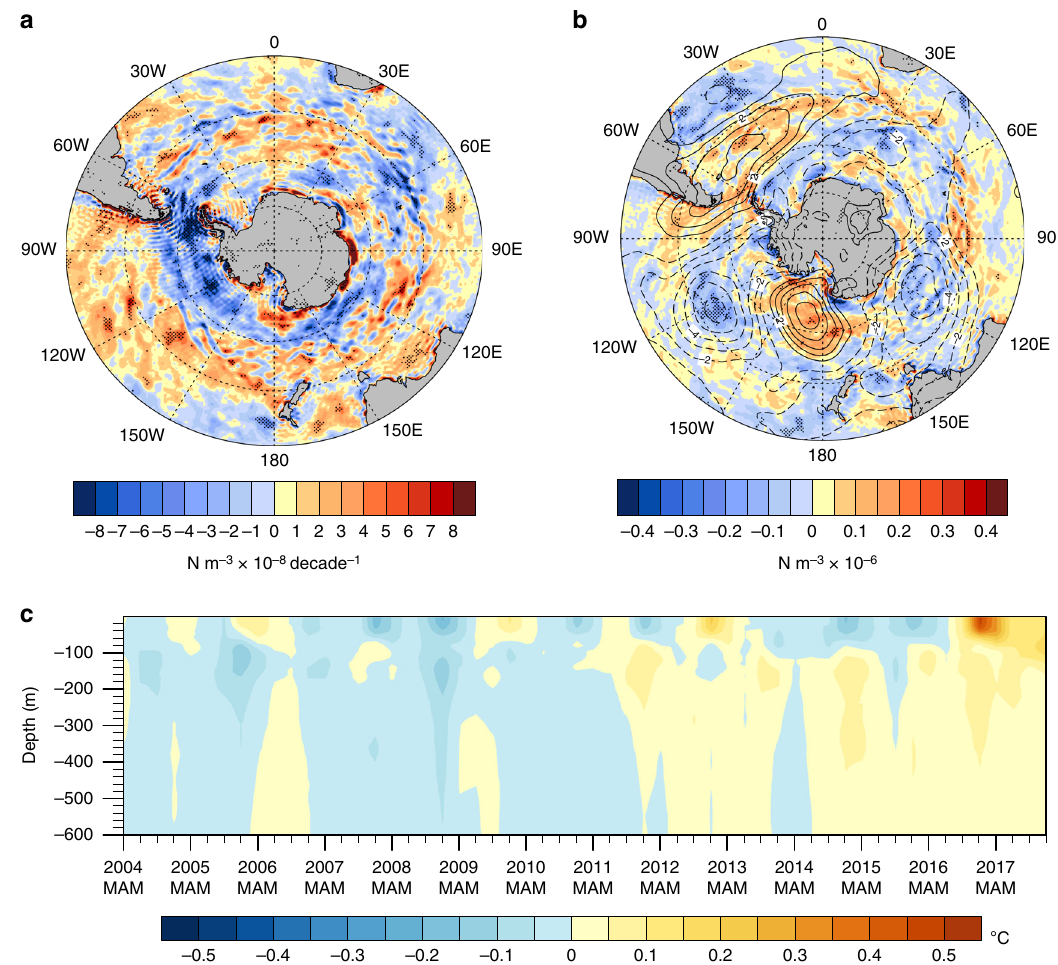
Fig. 4 Changes in wind stress curl and Southern Ocean response. a Linear trend from 2000 to 2014 of wind stress curl (N m − 3 × 10 − 8 decade − 1 ), computed from ERA-Interim wind stress, negative trend values denote areas of Ekman suction that would move water upward in the column; b SLP anomalies for SON 2016 (hPa, as in Fig. 2a) with SON wind stress curl anomalies superimposed as colors (N m − 3 × 10 − 6 ); c zonal mean seasonal temperature anomalies (°C) relative to 2004 – 2017 climatology from gridded Argo fl oat data for upper 600 m averaged over 50 –